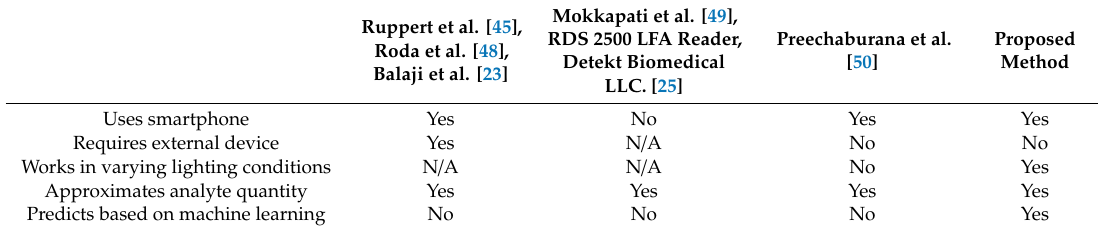
Table 8. Method comparison between existing methods and the proposed